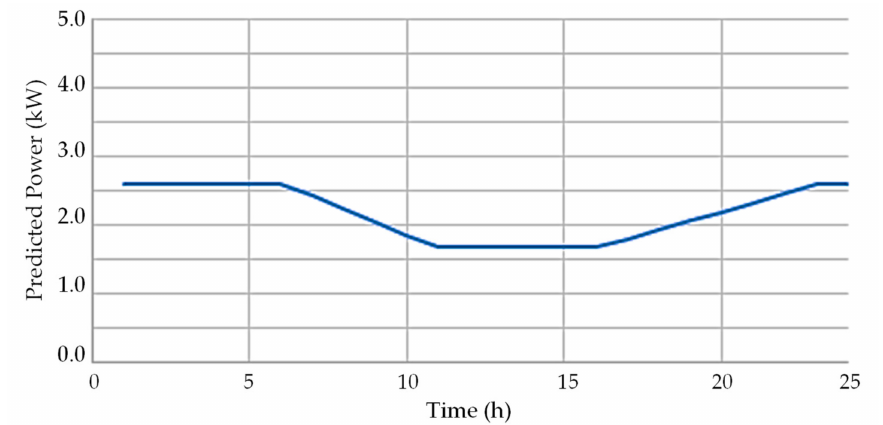
Figure 2. Stochastic predicted values for the heat, ventilation and air conditioning system in the day-ahead market.